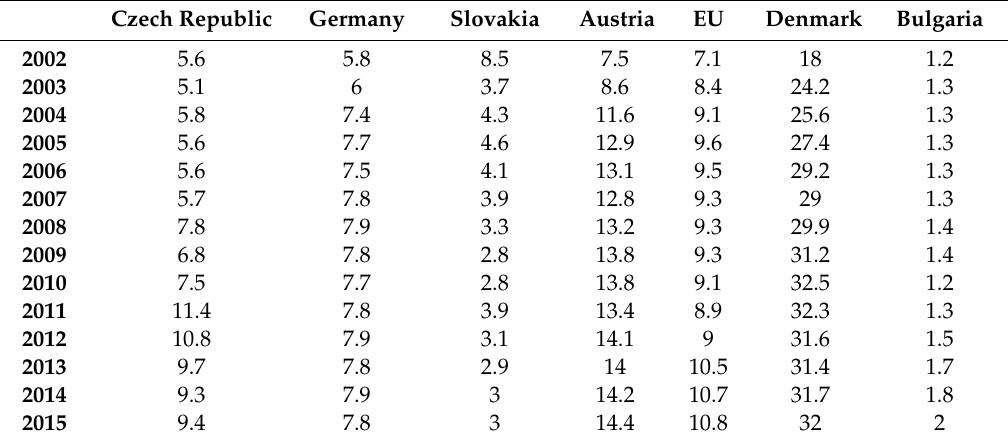
Table 3. Percentage of population (25–64 years) participating in education (%) in